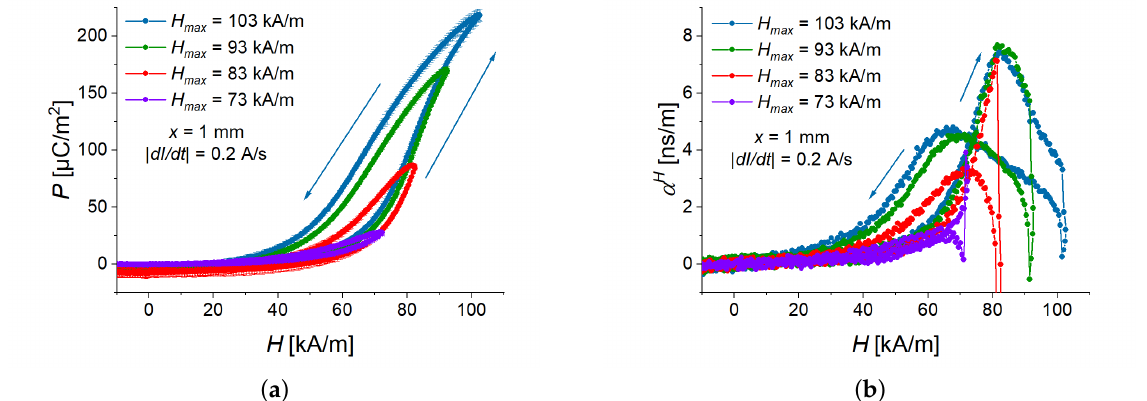
Figure 10. Field dependences of polarization ( a ) and ME coupling coefficient ( b ) for four peak values of magnetic field ( H max = 73, 83, 93, and 103 kA/m) for a sample with 1 mm thick MAE